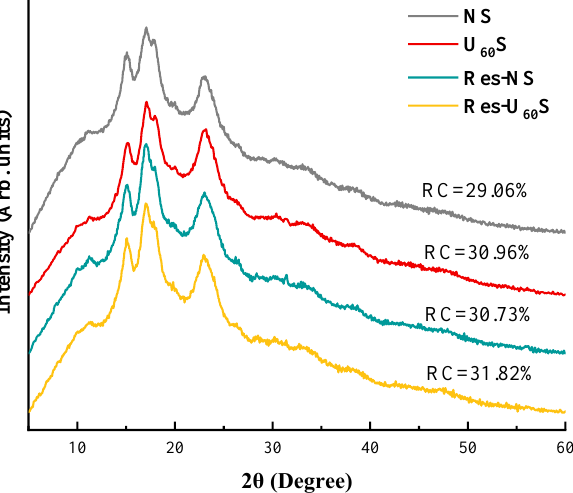
Figure 6. X-ray diffraction pattern and relative crystallinity (RC) values of four samples. The RC of the sample increased from 29.06% to 30.96% after ultrasonic treatment.